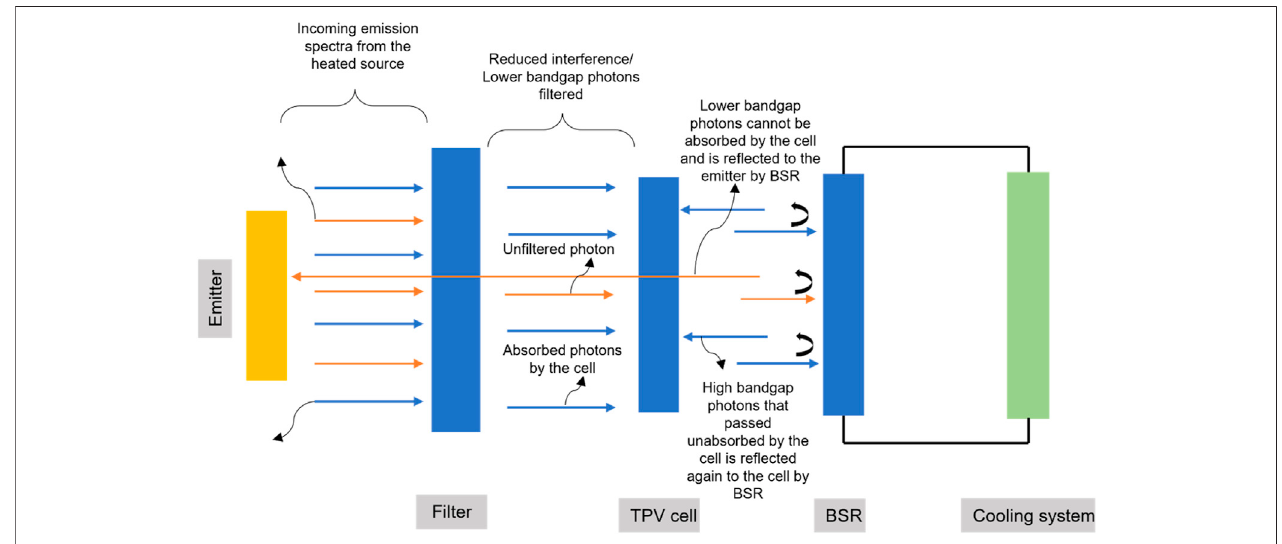
FIGURE 3 | TPV system with hybrid photon recycling technologies includes spectral fi lter and BSR in which concept of fi ltering and re fl ecting photons back to the front side of the TPV cell is explained.